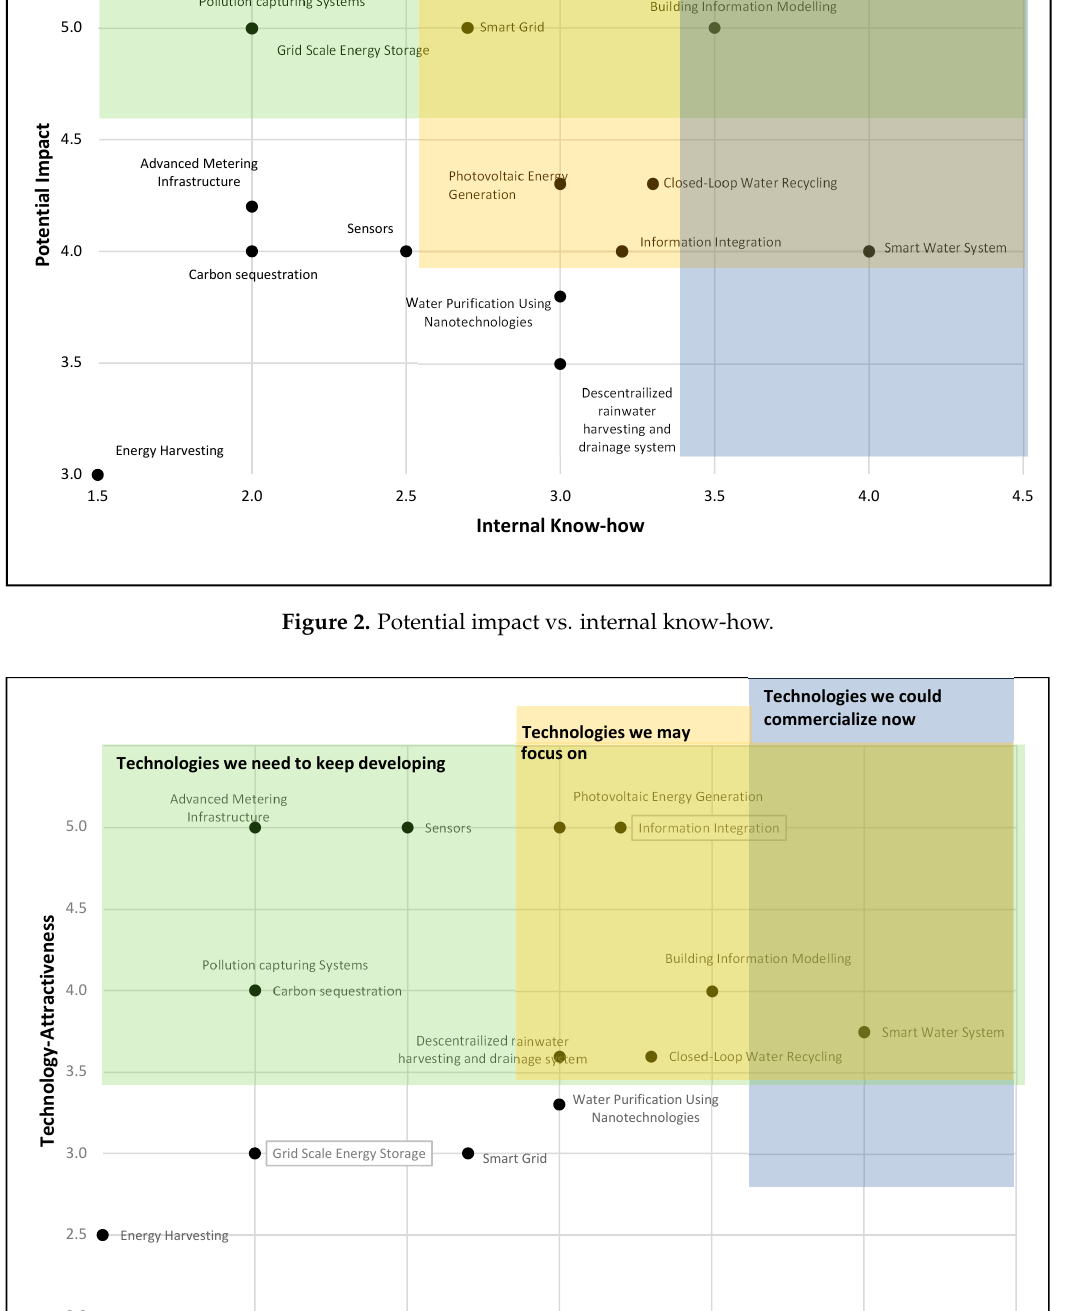
Figure 4. Complexity vs. internal know-how.